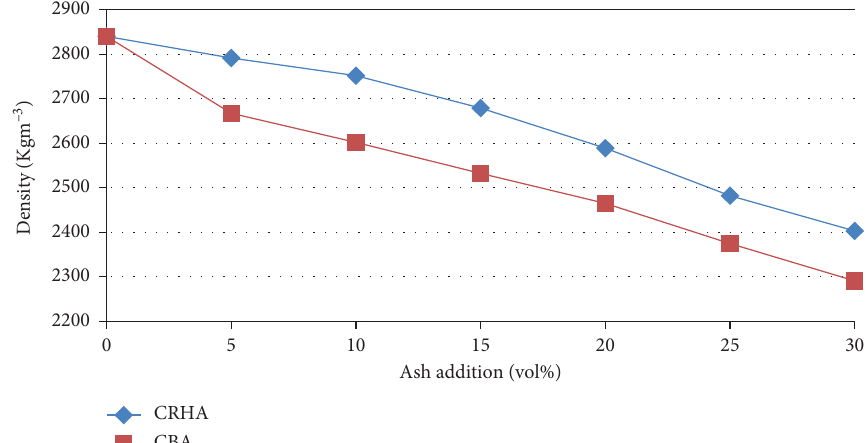
Figure 21: Effect of type and wt% of RHA and SCBA on density AMCs, adapted with permission from Ref. [131], copyright 2019, Elsevier.